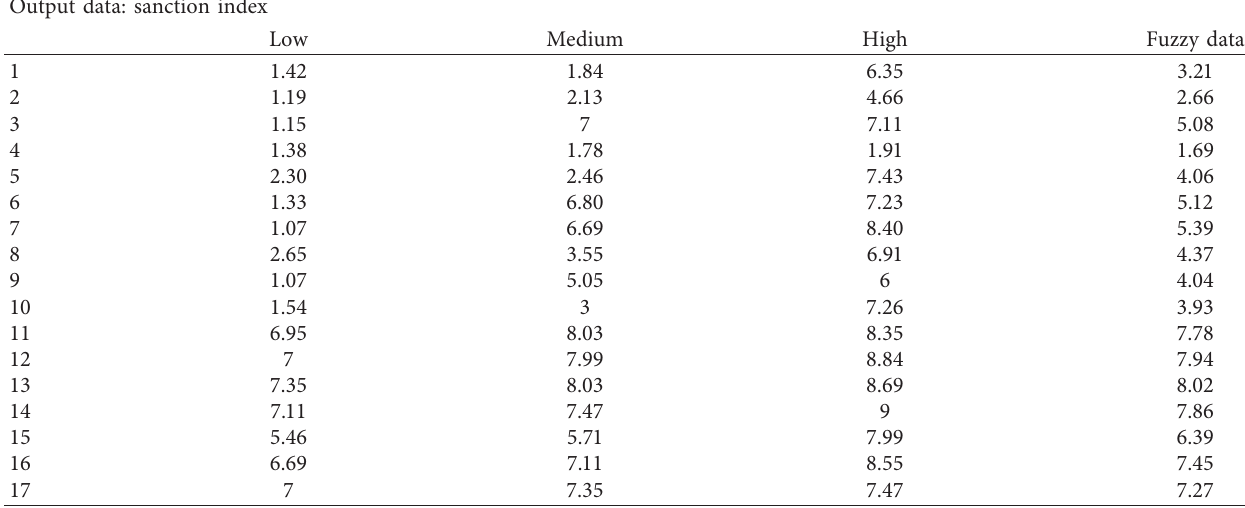
Table 3: Output data from the fuzzy system.